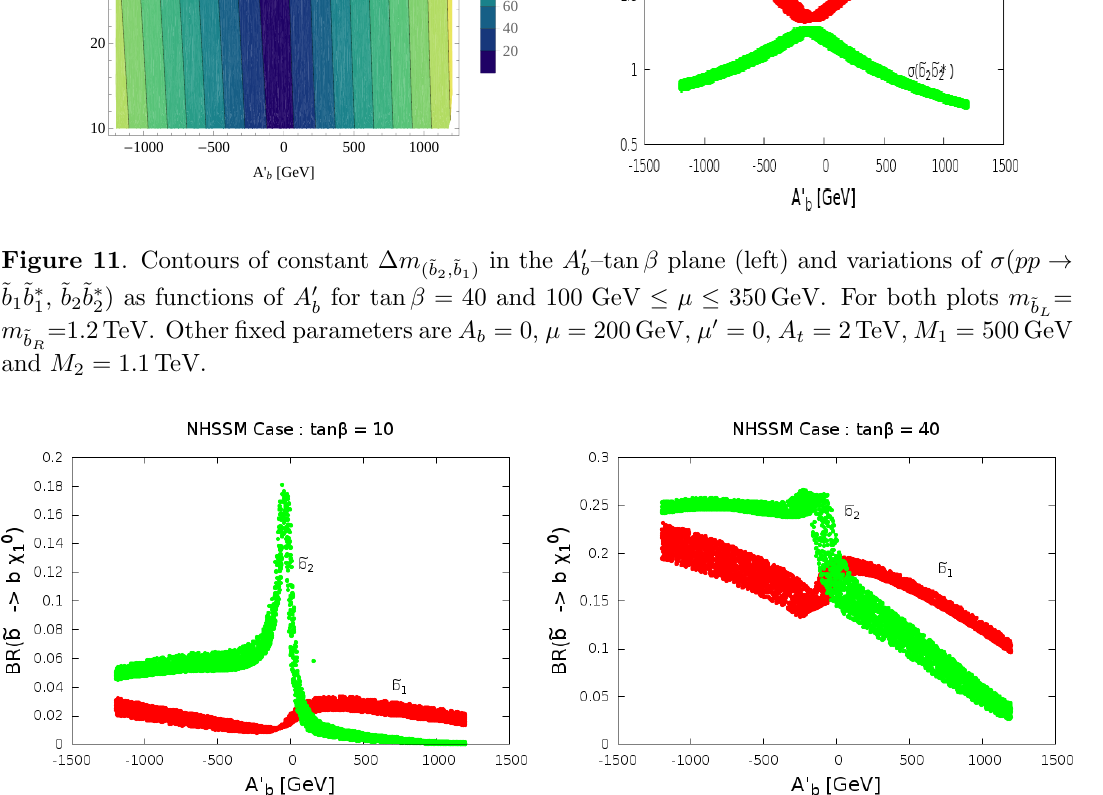
shown in red (green) as functions of A 0 1 = m ~ =1.2 TeV and (cid:22) 0 = 0 with 100 b L b R b(cid:31) 0 ]) in the 2 b + =E (cid:12)nal state arising from ~ b 1 = 2 ! T 1